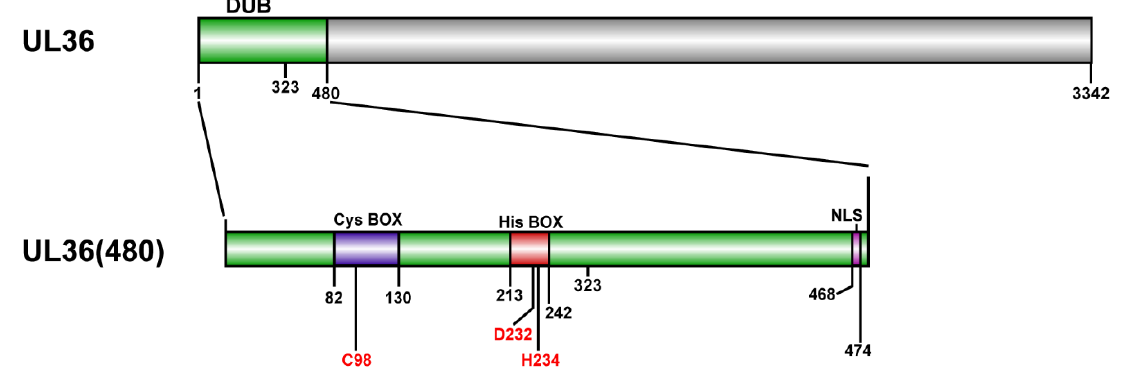
Figure 10. Diagram of UL36 encoded by Marek’s disease virus (MDV). Top chart indicates the full length of UL36; lower chart indicates UL36(480) fragment. The numbers are sites of the residues on UL36, where numbers in red are the predicted catalytic triad. DUB, the predicted DUB domain of UL36; NLS, nuclear localization sequence. Table 2. Primers for construction and mutation.